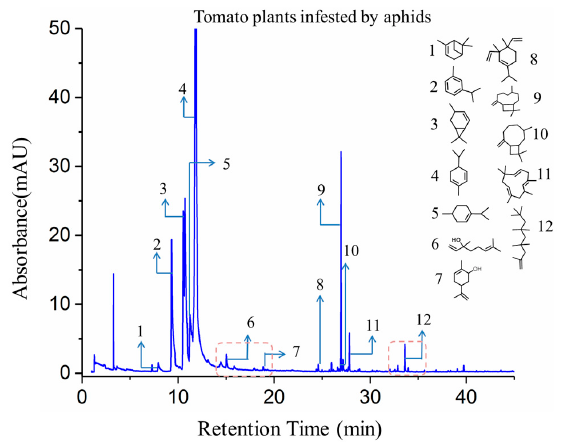
Figure 9. The GC-MS spectra of the VOCs released from aphid-stressed tomato plant.